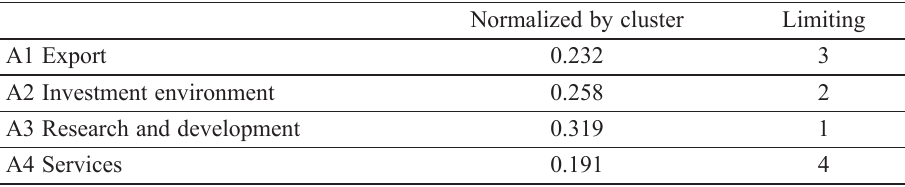
Table 11. Prioritization of the alternatives under the cost sub-network